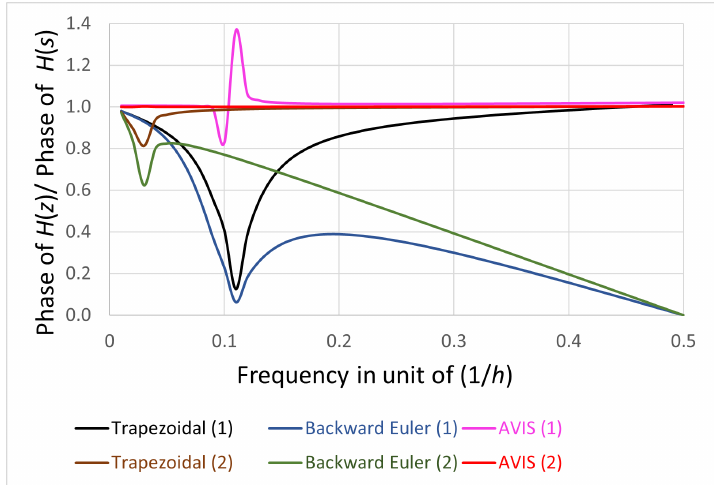
Figure 5. Phase ratio of the frequency response of the integration rules ( h = 0.2